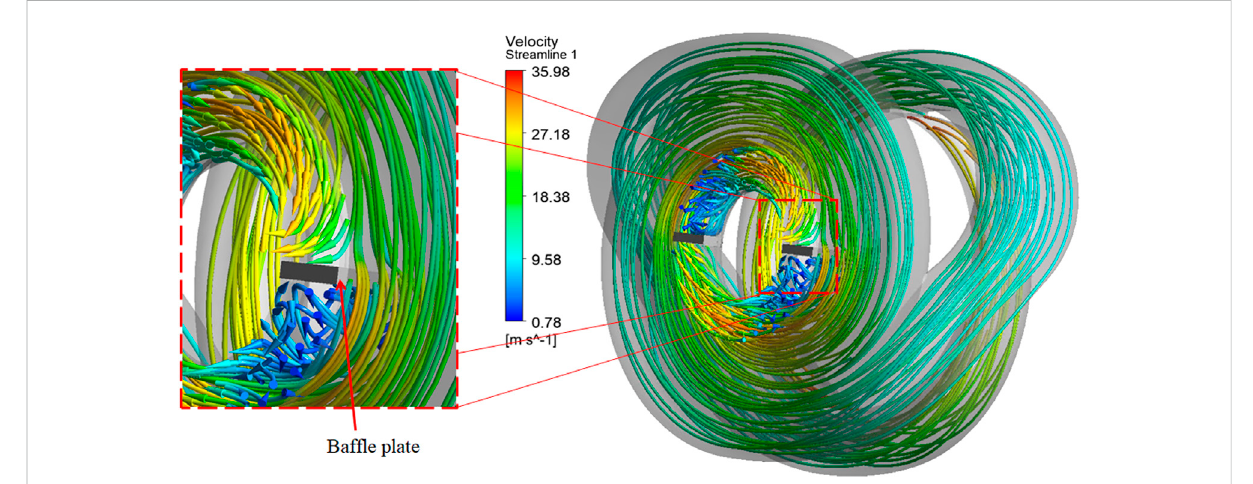
FIGURE 10 Velocity streamline at the volute exit of baf fl e 2